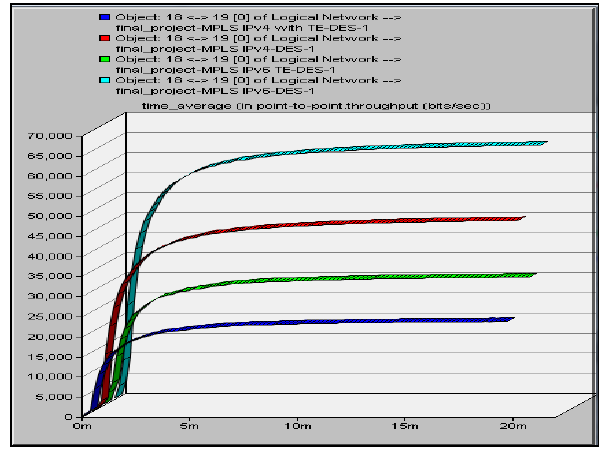
Throughput Comparison of IPv4